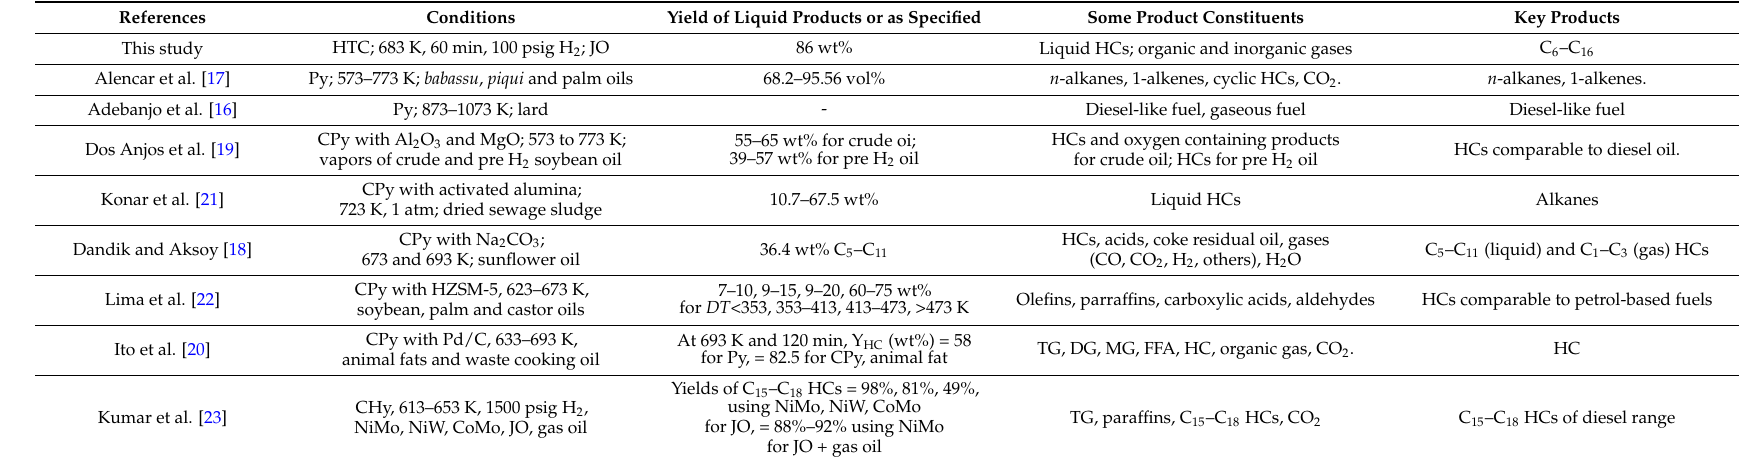
Table 6. Comparison of some results of this work with those of others. DG: diglyceride; FFA: free fatty acid; HTC: Thermal cracking with hydrogen; MG: